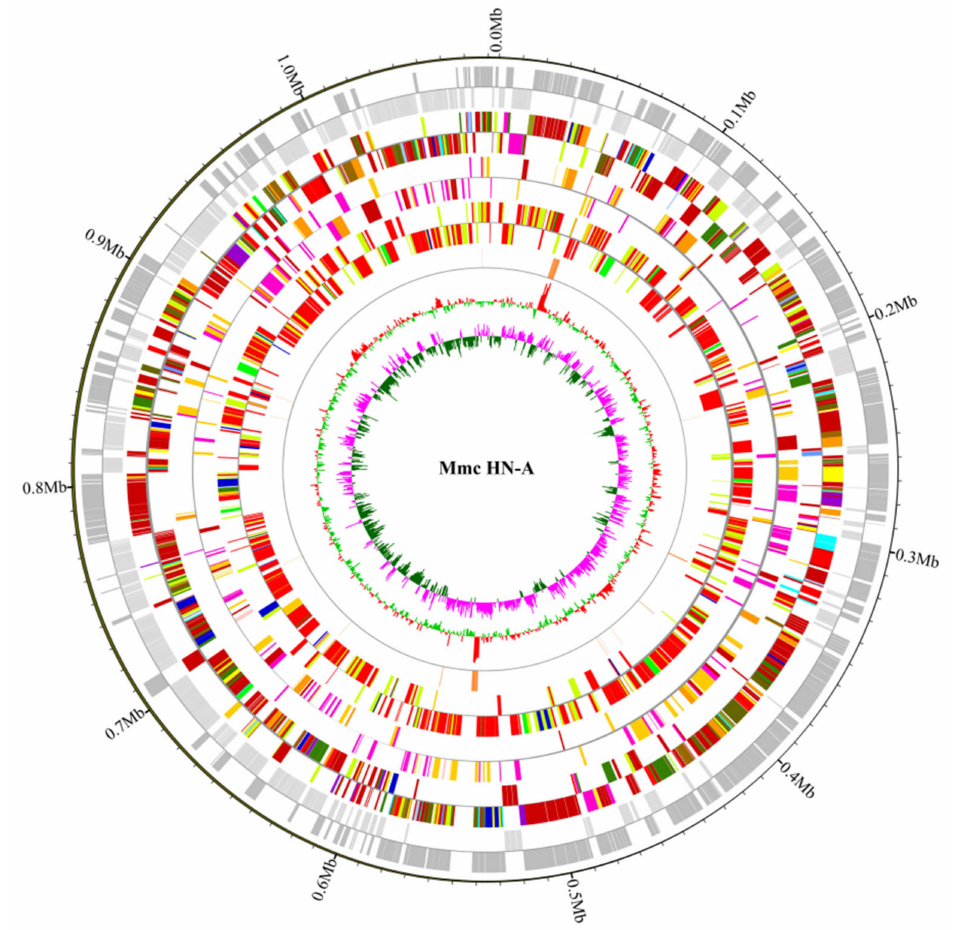
Figure 2. Whole genome map of Mmc HN-A. The outermost circle represents the positional coordi- nates of genome sequences. From the outer circle to the inner circle are coding genes, COG database annotation results, KEGG database annotation results, GO database annotation results, ncRNA, GC content, and GC skew (GC offsets were used to mark start and end points in circular chromosomes; both the window and step size were 1000). Table 2. General characteristics of Mmc